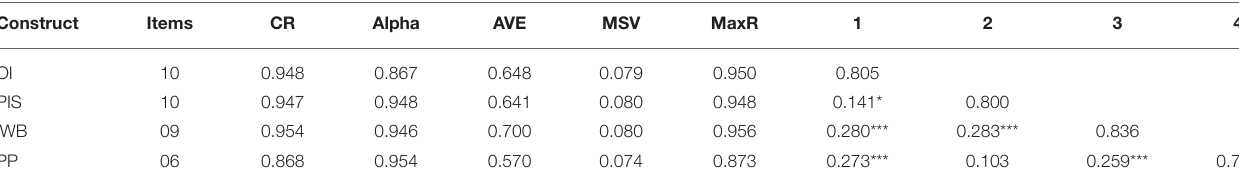
TABLE 6 | Validityand